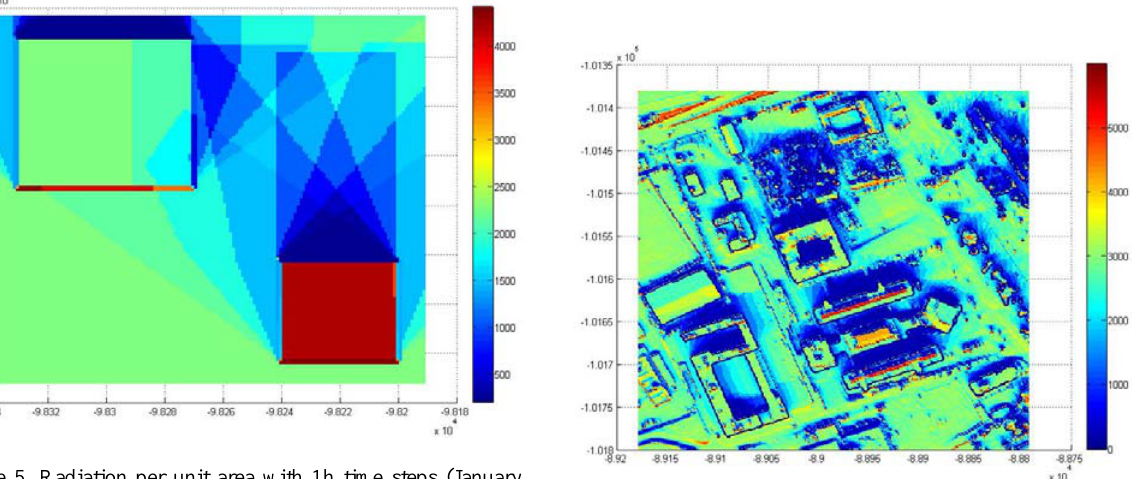
Figure 5. Radiation per unit area with 1h time steps (January, the 1 st ) [Wh/m 2 ].